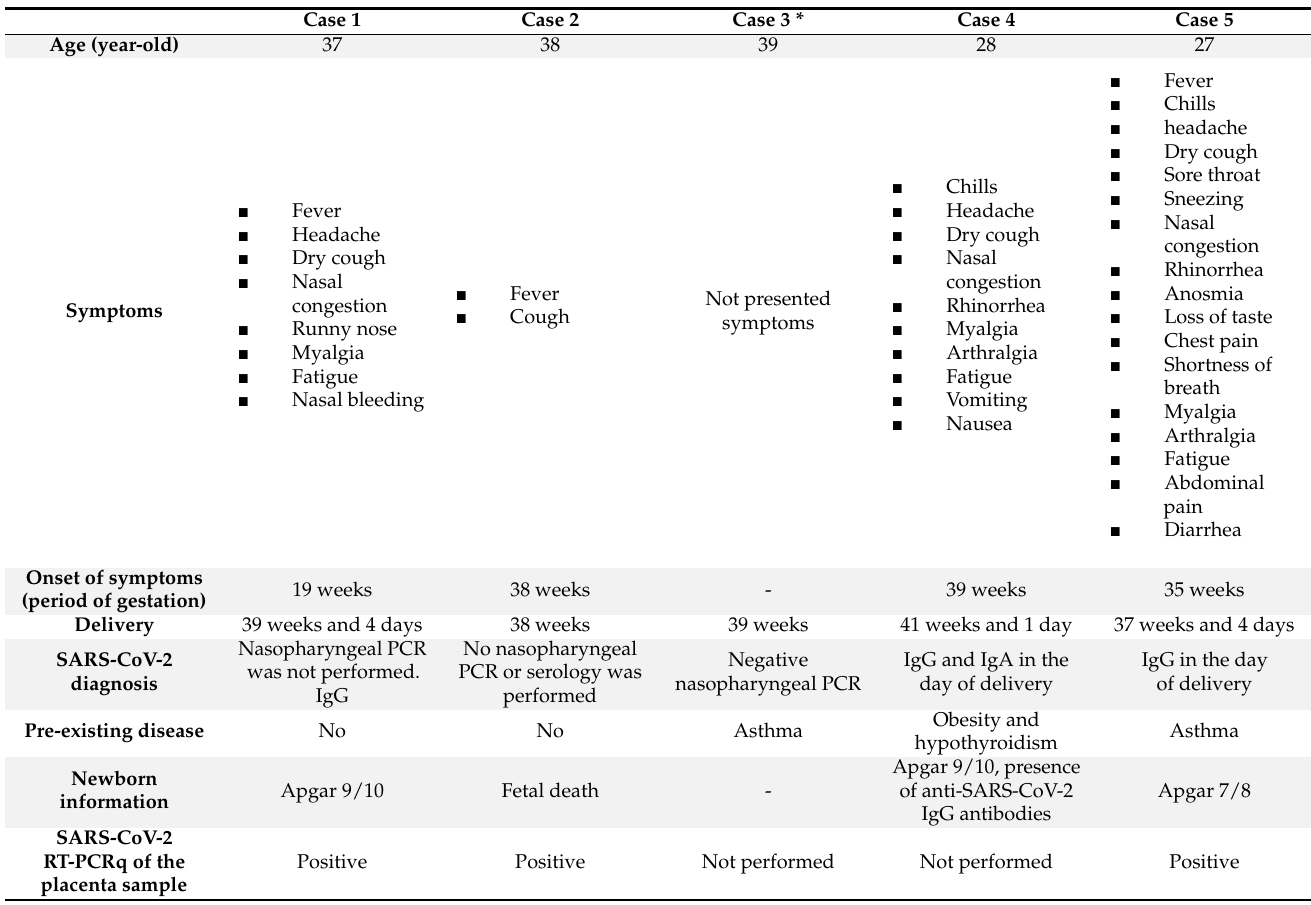
Table 1. Clinical and demographic description of the five cases. * This case was considered for analysis because, although asymptomatic, the baby was stillborn during the high pandemic outbreak period and subsequently confirmed the SARS-CoV-2 detection by